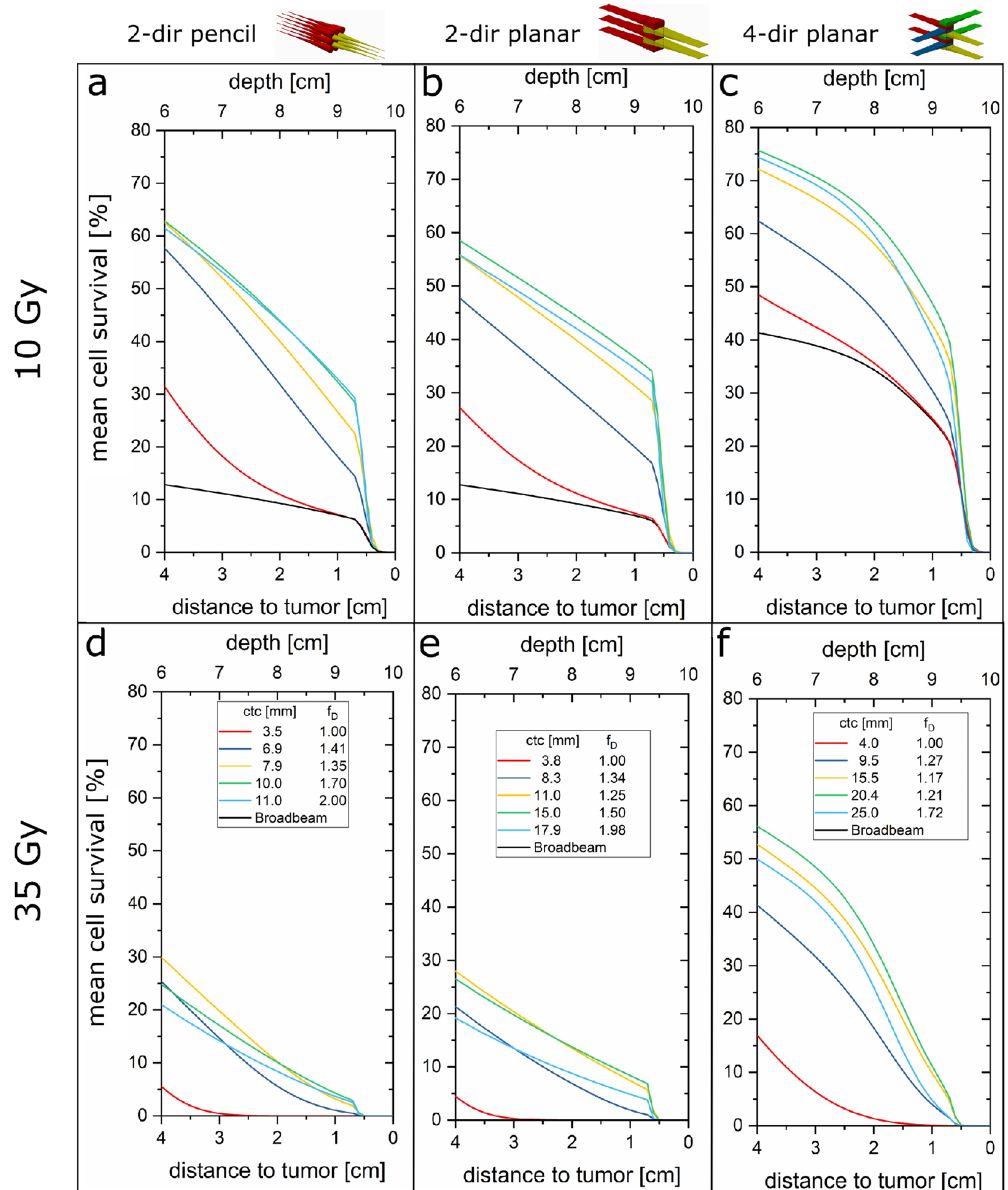
Figure 6. Mean cell survival results for the heterogeneous vs. homogeneous irradiation with 2-dir pencil ( a , d ) or planar ( b , e ) minibeams as well as 4-dir planar minibeams ( c , f ) at the close vicinity of the tumor using the two-Gaussian model from LAP-CERR 30,31 . The high doses of 10 Gy and 35 Gy minimum dose are presented in the upper row ( a – c ) and lower row ( d – f ), respectively. The cell survival for 35 Gy broadbeam irradiation is equal to 0 for all